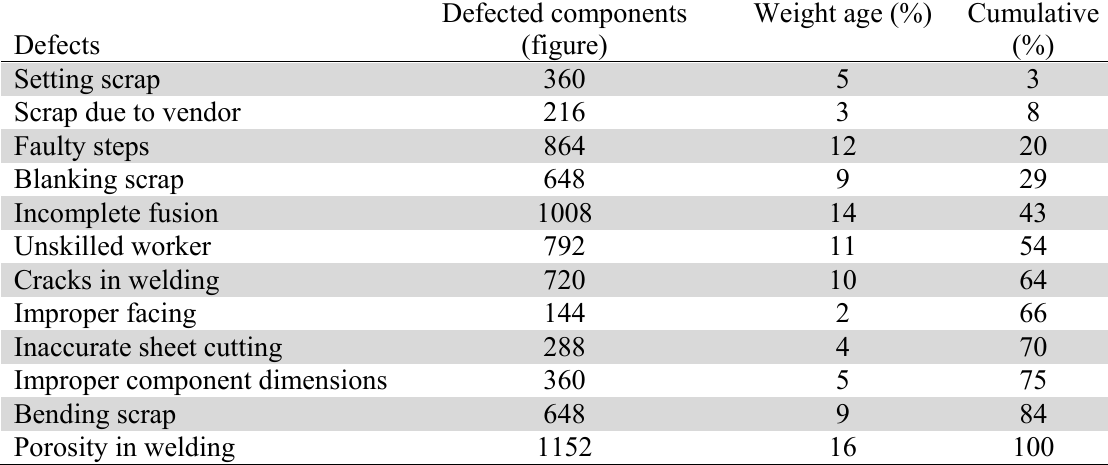
Defects and their contribution to total production Defects